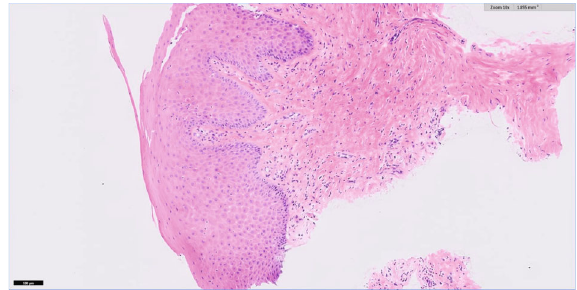
Figure 13: Histopathological slide of gingival biopsy revealed squamous epithelium hyperplasia with underlying chronic in fl ammation.